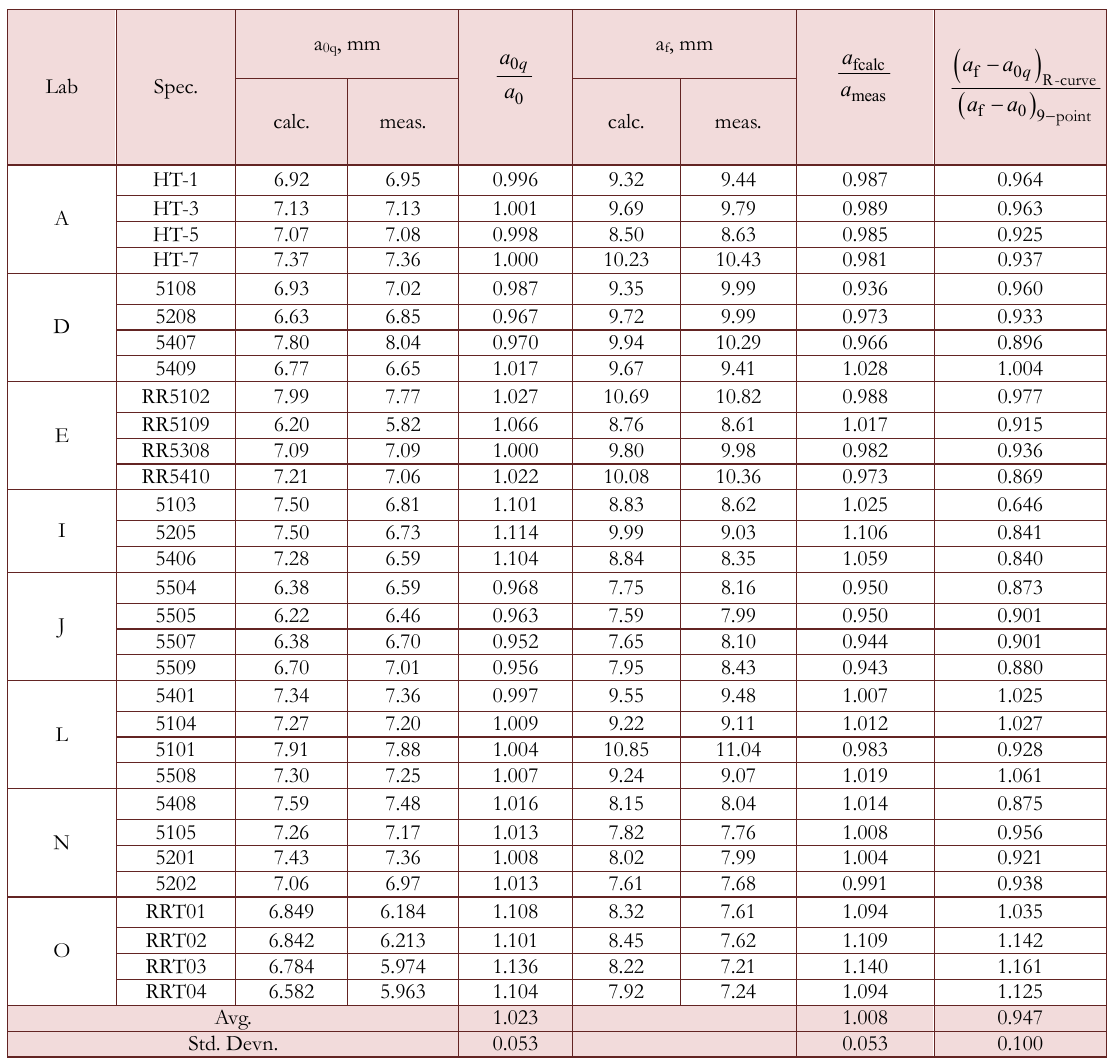
Table 1: Results of CANMET round robin: a 0q and a 0 are initial calculated and measured crack size values respectively, and a f is the final crack